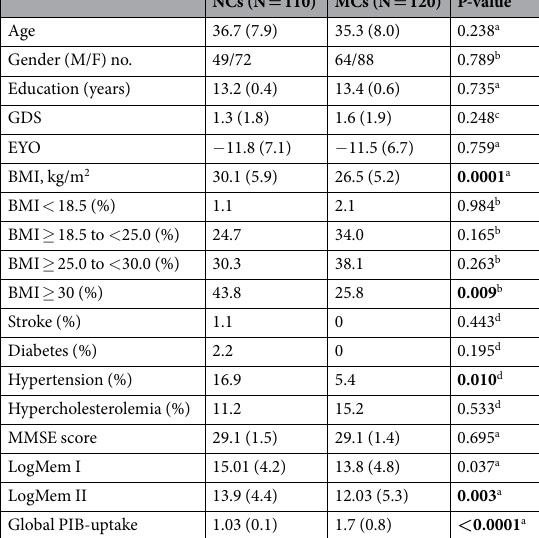
Table 1. Baseline demographics, body mass index, clinical, cognitive, biochemical and imaging parameters in preclinical (CDR = 0) mutation carriers (MCs) and non-carriers (NCs). Note: Displayed are means and standard deviations (SD); MCs = mutation carriers; NCs = non mutation carriers; a ANCOVA comparisons at Bonferroni adjusted p < 0.006 level of significance; b Pearson chi-square test; c Mann-Whitney U test; d Fisher’s exact test; CDR = Clinical Dementia Rating scale; M = male; F = female; GDS = Geriatric Depression Scale; BMI = body mass index; no. = number; % = percentage; EYO = estimated years to symptom onset; MMSE = Mini-Mental State Examination; LogMem I = Logical Memory test, immediate recall; LogMem II = Logical Memory test, delayed recall; Global PIB-uptake = global cerebral A β burden as measured by 11 C-Pittsburgh Compound-B